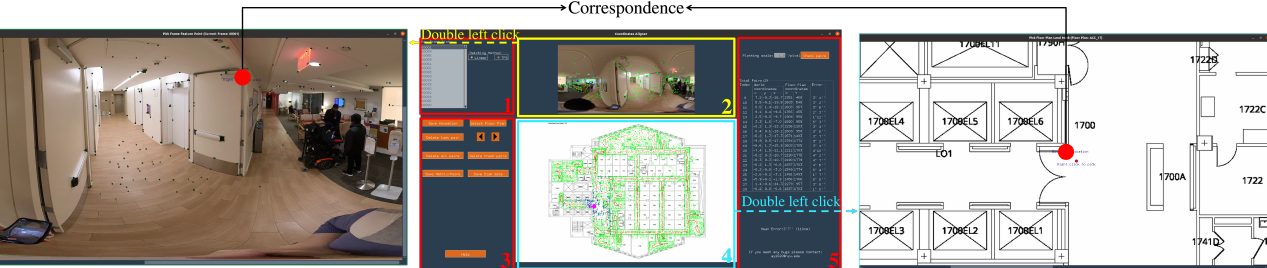
Figure 2. Topometric map-aligner GUI. The main window is displayed in the middle, which com- prises five zones. Zone 1 has a list of all equirectangular images recorded in the target space, which can be browsed in Zone 2 . Several buttons in Zone 3 aid the map-maker in projecting the raw map onto the floor plan. The map-maker can upload and display the floor plan of the target space in Zone 4 by clicking the ‘Select Floor Plan’ button in Zone 3 . Two magnified views ( left and right ) aid the cartographer in locating the 2D–3D correspondences between the equirectangular image and the floor plan. Once the transformation matrix is identified, Zone 5 will display map error